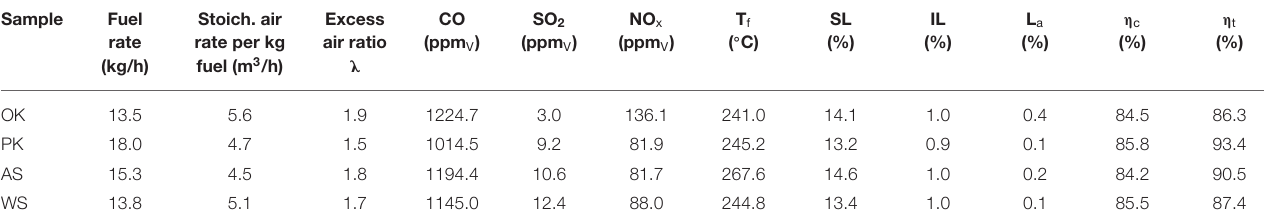
TABLE 3 | Combustion characteristics of the fuels (average values) at steady state. Sample